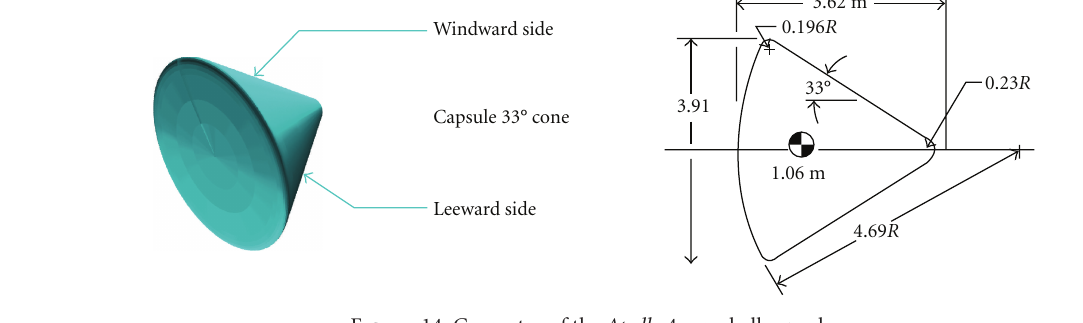
Figure 14: Geometry of the Apollo 4 aeroshell capsule. Table 3: Apollo 4 Trajectory data calculated by Sparta trajectory